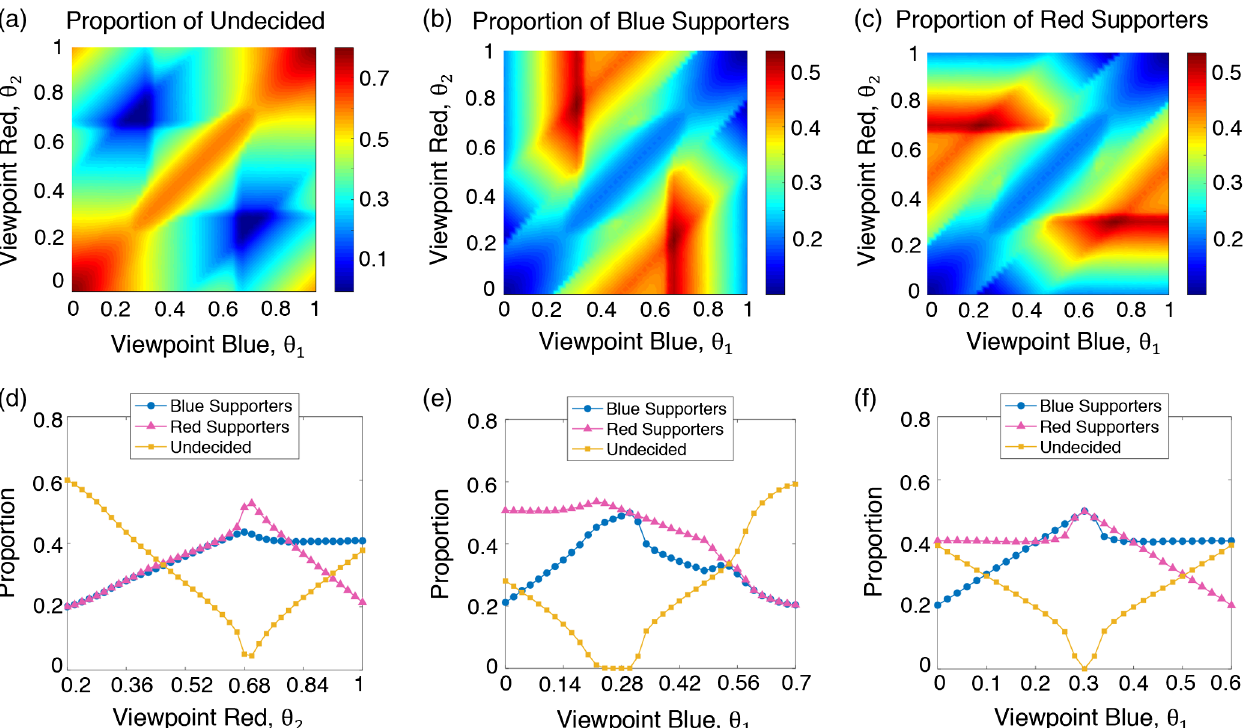
FIG. 5. Competing campaign ideologies within social networks. We can also use our model to see how campaigns should ideologically position themselves to maximize voter appeal. We assume that, in the short run, the open-mindedness (identity scope) of voters and levels of discussion partner and candidate influence on voters remains constant, so we fix δ 1 ¼ 0 . 18 and μ 1 ¼ μ 2 ¼ 0 . 5 . (a) – (c) show how vote shares for blue, red, and undecided varies as a function of the candidate ’ s ideological positions. Both candidates maximize vote share by picking opposing positions in the ranges of [0.2, 0.3] and [0.7, 0.8]. In (d),(e), the ideological viewpoint of one campaign is fixed [(d) θ 1 ¼ 0 . 2 and (e) θ 2 ¼ 0 . 7 ] and the other is varied. In (f), the difference between the two campaigns is fixed ( δ 0 ¼ 0 . 4 ), and maximum vote share for both candidates occurs when the campaigns are equidistant from 0.5 ( θ 1 ¼ 0 . 3 and 0 . 7 ). All simulations begin with an ER graph with N ¼ 10 4 , h k i ¼ 6 , and Ω 0 . 5 . Simulation results are averaged over θ 2 ¼ T ¼ 100 independent